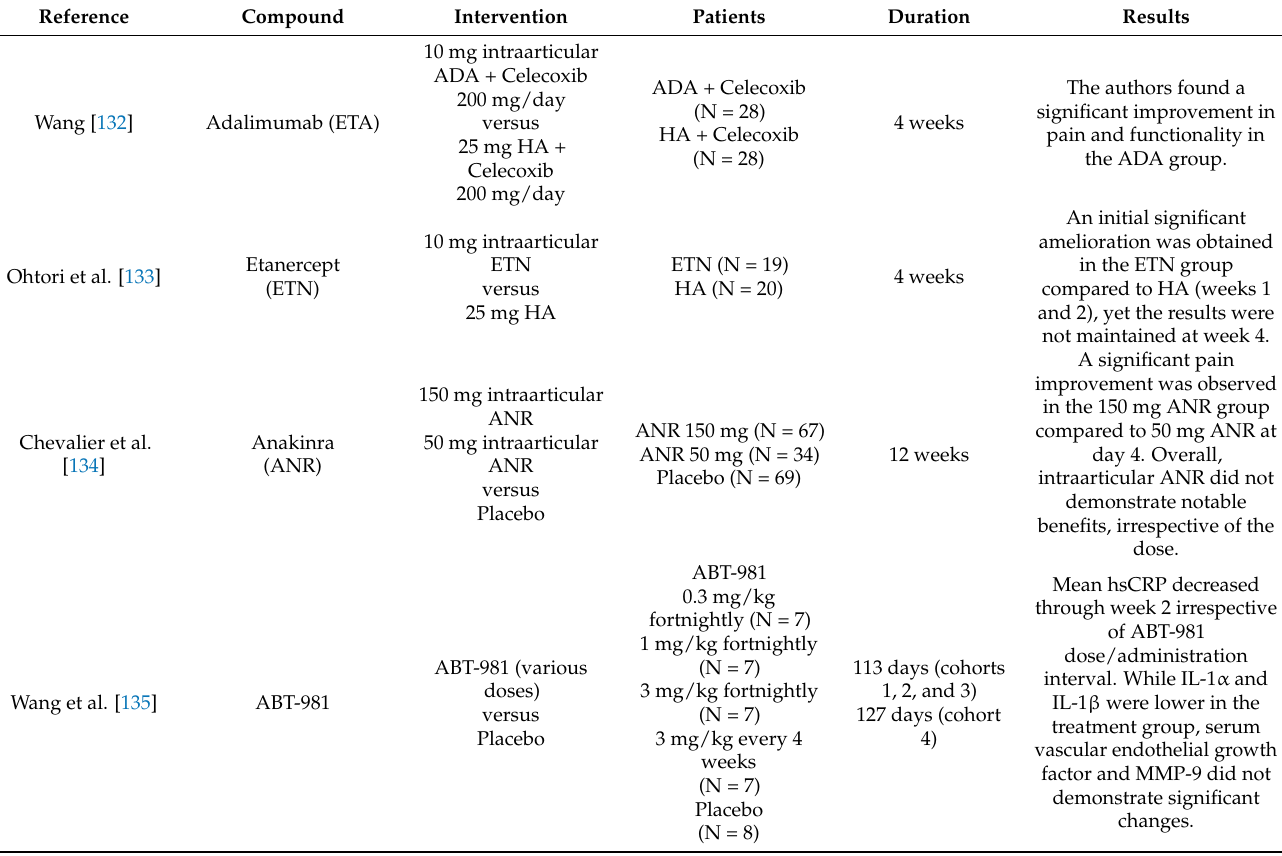
Table 1. Proinflammatory cytokine blockers adalimumab, etanercept, anakinra, and ABT-981 in knee OA.